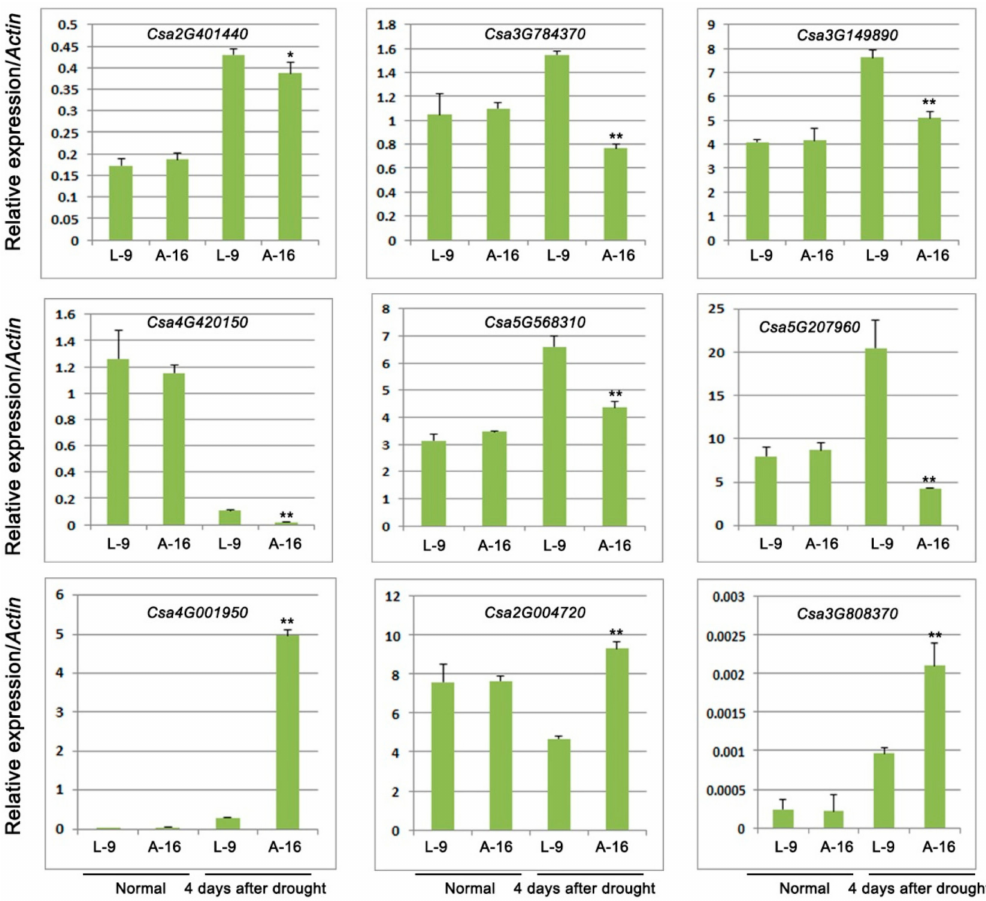
Figure 7. Relative expression of genes related to sucrose biosynthesis and response to water deprivation.